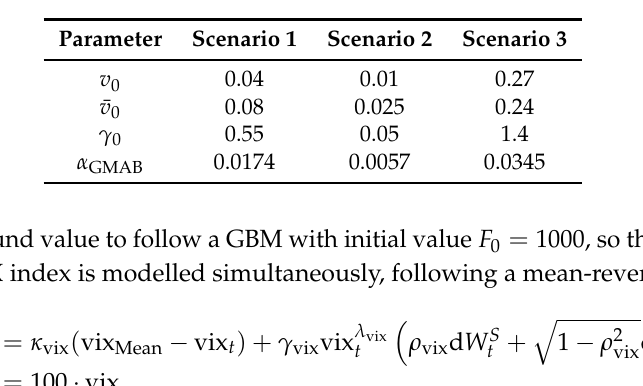
Table 4. Initial values and fair premiums of the GMAB